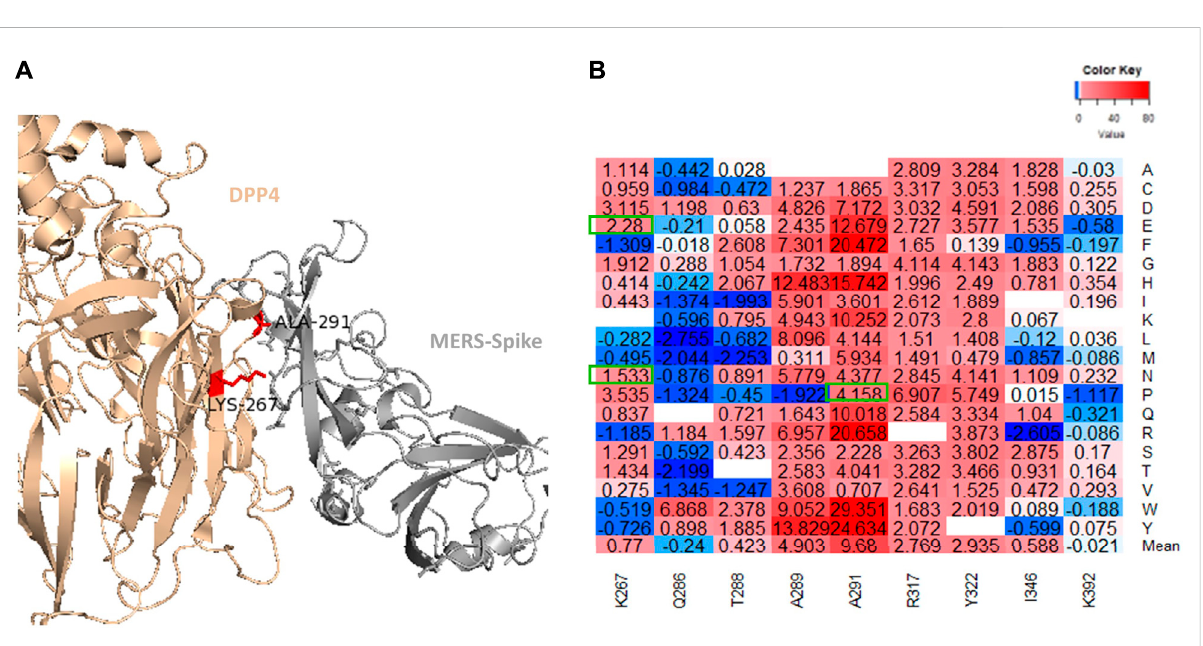
FIGURE 7 (A) Illustration of the MERS-CoV S protein and DPP4 interface with the K267 and A291 residues displayed. (B) The binding af fi nity heatmap and ΔΔΔ G values for mutations generated in each position investigated by Kleine et al.